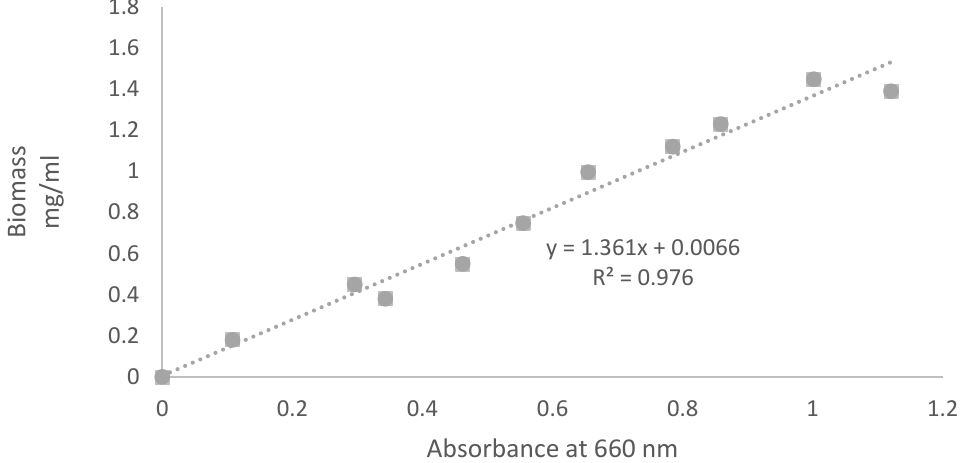
00.20.40.60.8 Figure 1. Calibration curve between algae biomass and absorbance at 660 Figure 1. Calibration curve between algae biomass and absorbance at 660 nm.